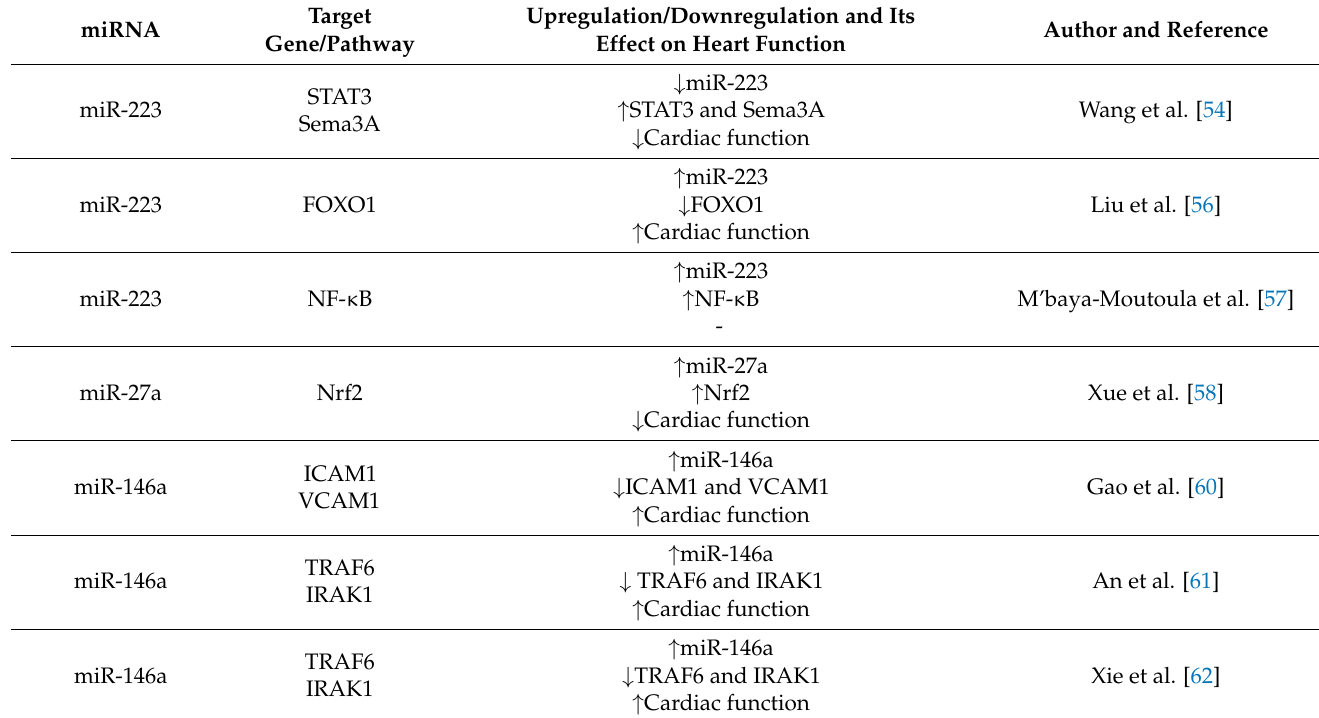
Table 8. miRNAs involved in sepsis-induced heart dysfunction and their targets. ↑ indicates up regulation, ↓ indicates down